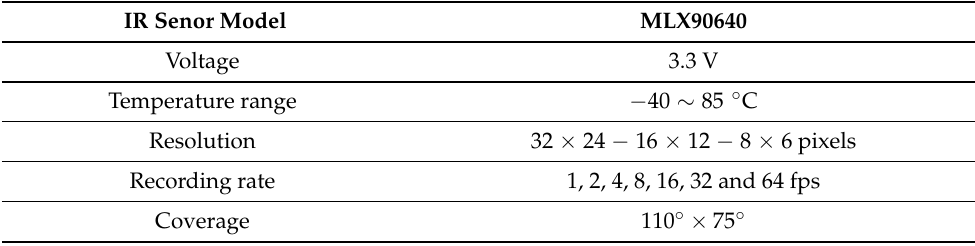
Figure 1. The IR array sensor used for our experiments. Table 1. Specifications of the IR array sensor used for our experiments.